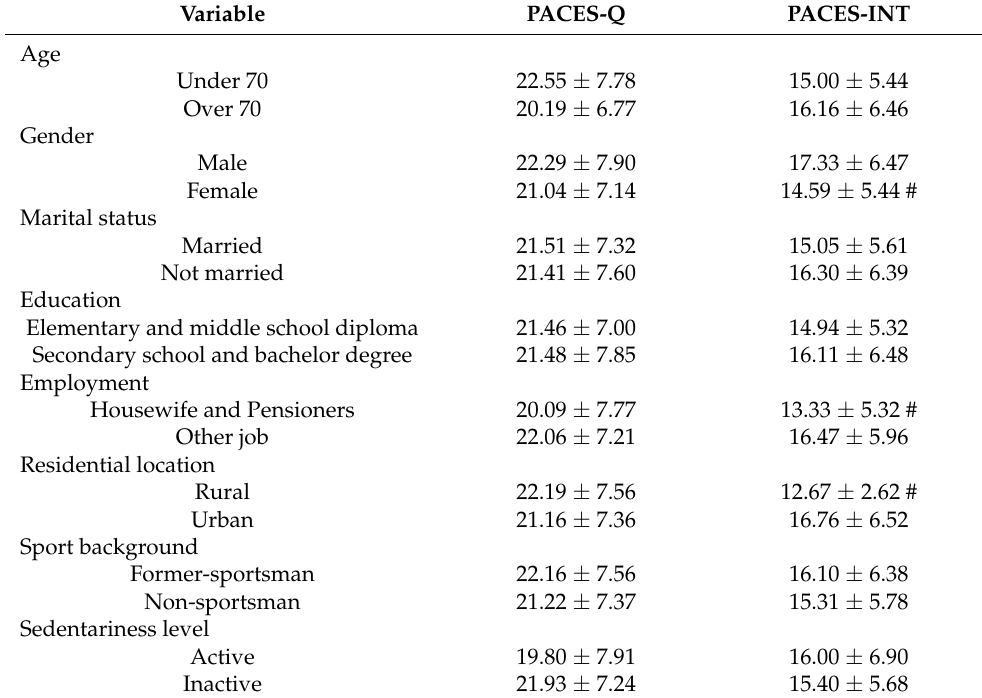
Table 2. PACES-Q and PACES-INT results of the sample subgroups (mean ± SD). Variable PACES-Q